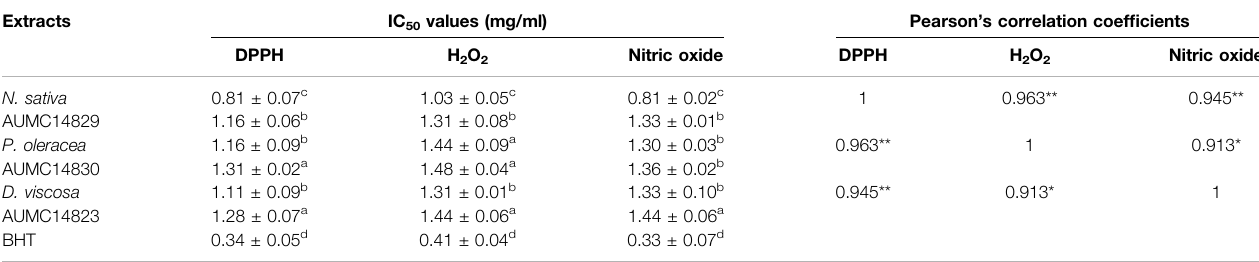
The data were given as averages of three replicates (Mean ± SE). Values followed by the different letters are signi fi cantly different at p ˂ 0.05. *Correlation is signi fi cant at the 0.05 level (2-tailed). **Correlation is signi fi cant at the 0.01 level